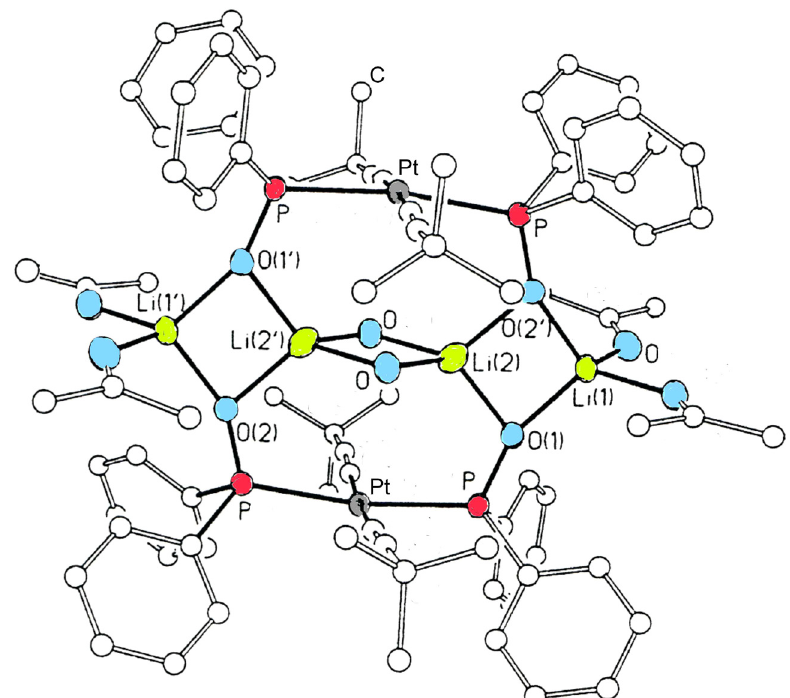
Figure 4. Structure of [(BuC ≡ C)